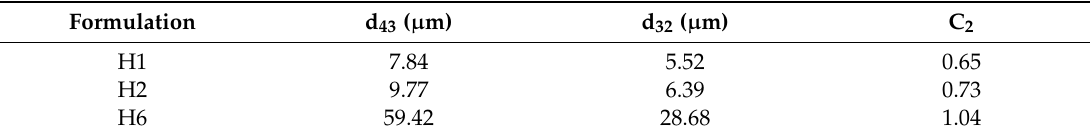
Table 3. Droplet size analysis performed on the confocal images of the di ff erent emulsions (Figure 5) using ImageJ